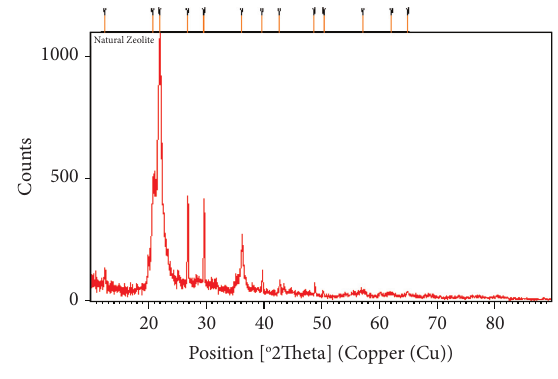
Figure 3: Natural zeolite XRD